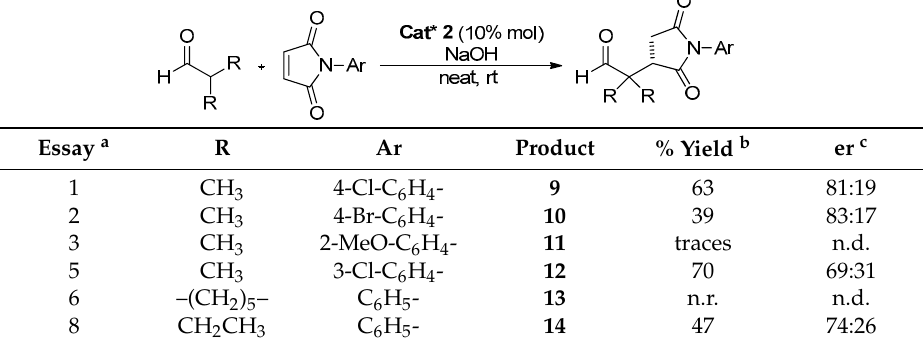
Table 4. Michael addition reaction of aldehydes to different N -substituted maleimide substrates.